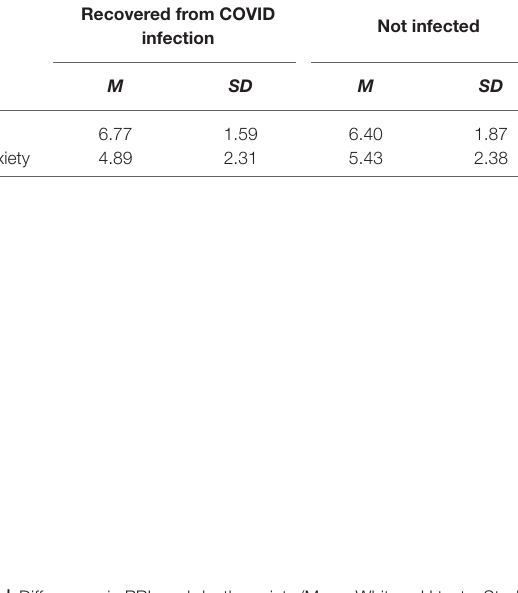
TABLE 6 | Differences in PRL and death anxiety (Mann–Whitney U tests, Study 2). Recovered from COVID infection